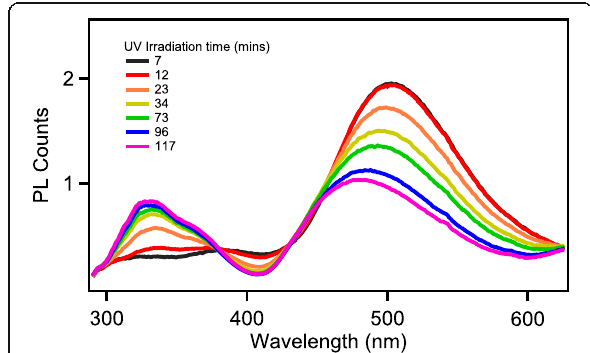
Fig. 6 Steady PL of monolayer nano-graphene after different UV exposure periods